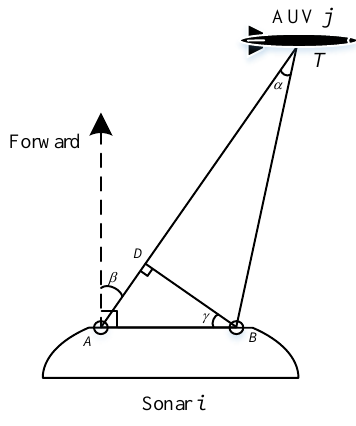
Figure 4. Schematic diagram of the relative direction detection.